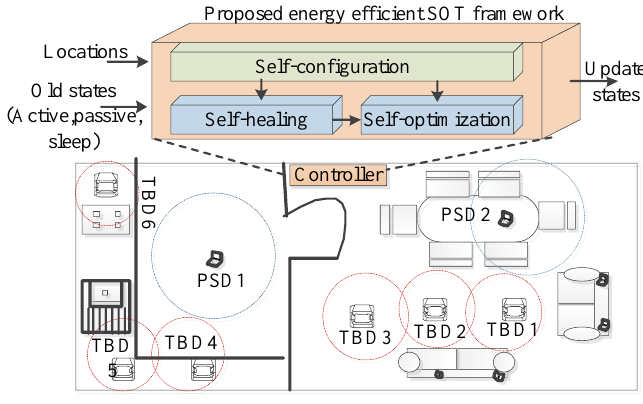
Figure 9. Network topology using SOT.